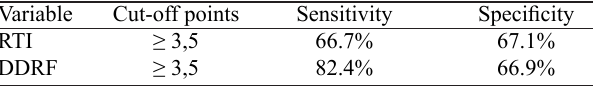
Table 8. Cut-off points and sensitivity and specificity values.